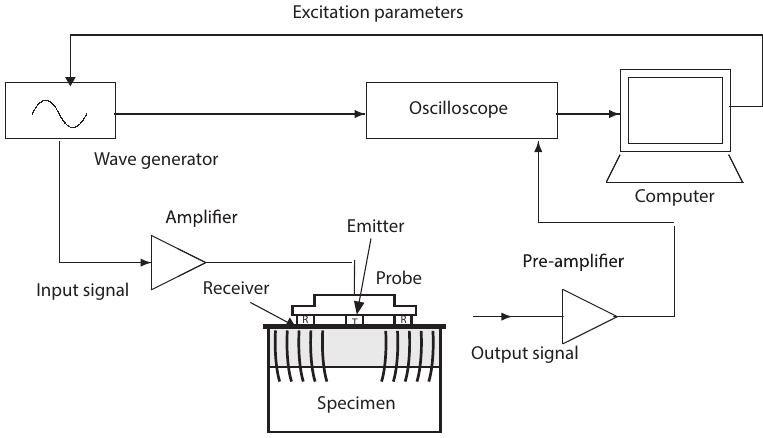
Figure 2. Experimental configuration of the excitation–propagation measurement